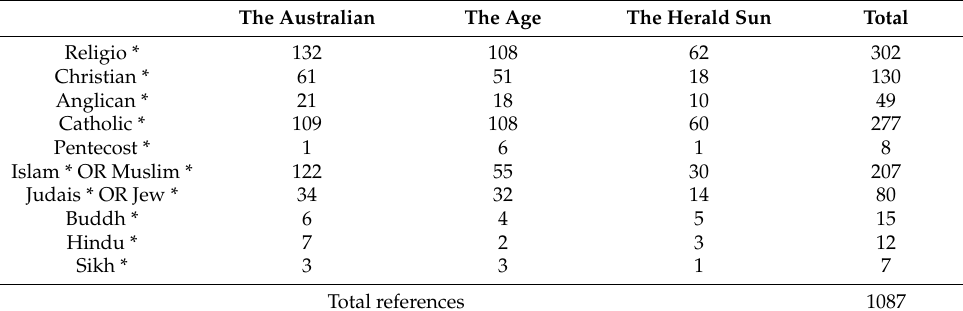
Table 5. Conventional Religion references across the newspapers.